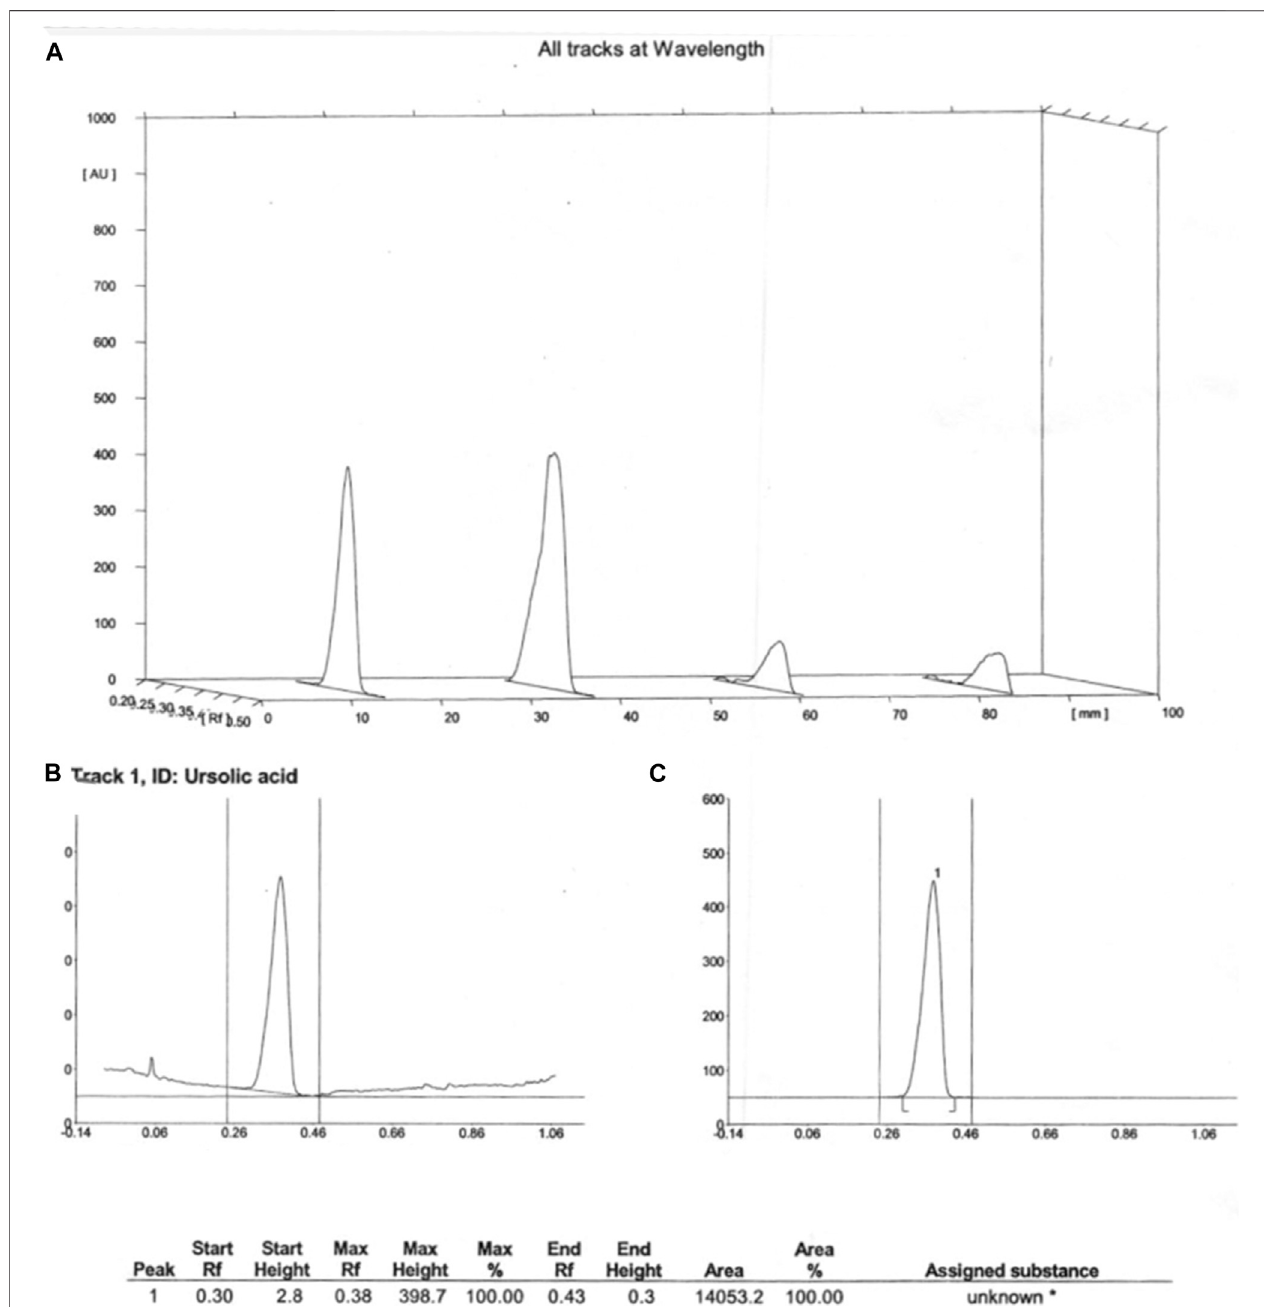
FIGURE 2 | UV scanning chromatogram of plant extract (A) and ursolic acid standard (B,C) .